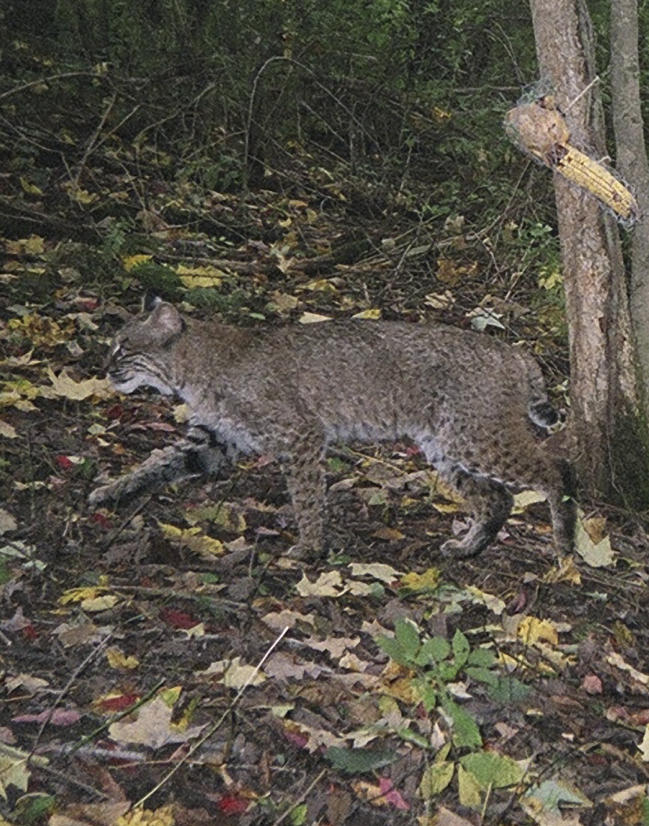
A Bobcat (
Lynx rufus) Drawn to a Scent Lure Placed near an Infrared-Triggered Camera
This species is highly sensitive to forest fragmentation, requiring extensive tracts of habitat to support viable populations. Bobcats and other species of mammalian carnivores are important components of diversity that appear to function both as regulators of pathogen reservoirs such as white-footed mice and as hosts that might deflect tick meals away from more competent reservoirs for zoonotic pathogens.